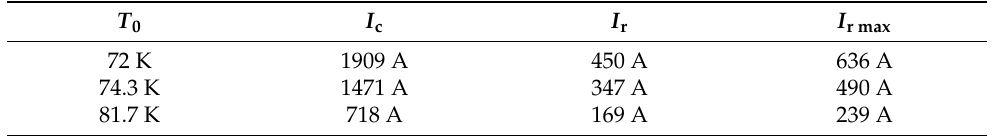
Table 7. Maximum and final temperature of the limiter acc. Figure 16 .